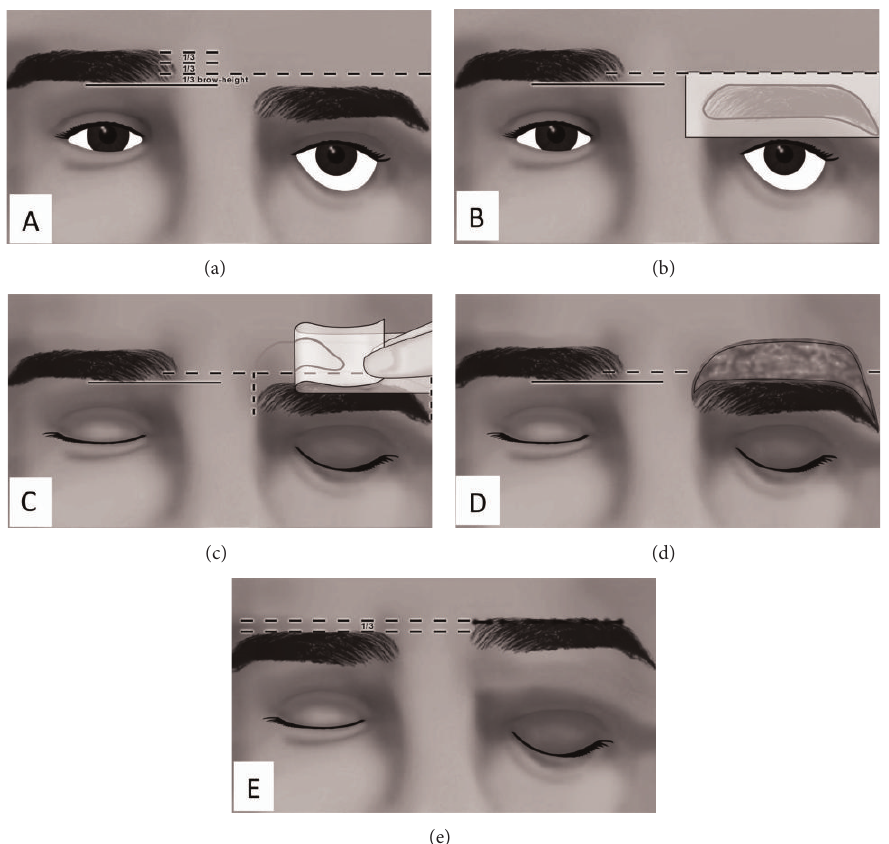
Figure 2: Interrupted line extends at the level of 1/3 height of normal brow to the ptotic brow. Continuous line demarcated the inferior edge of the contralateral brow (a). Copy . The brow shape is copied on a transparent paper (b). Paste . The brow copy is localized on the interrupted line. By pasting the paper, the brow shape is copied above the ptotic brow (c). Excise . Excision of the outlined area (d). Stitch. Direct and layered closure (e).